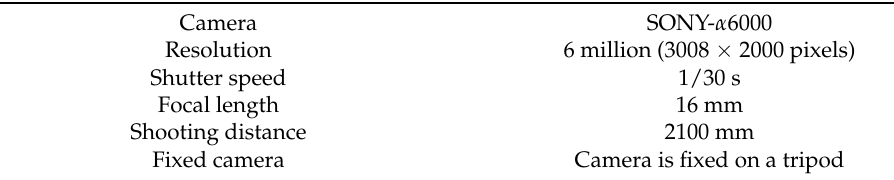
Figure 2. Original image captured by a fixed camera. Table 1. Shooting condition of a fixed camera.